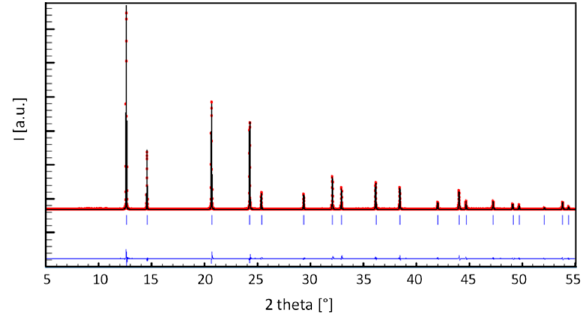
Figure 2. Rietveld refinement plot of sample NdDy20. The dotted (red) and the continuous (black) lines are the experimental and the calculated diffraction pattern, respectively. The lower line is the difference curve, and vertical bars show the calculated positions of Bragg peaks. Table 1. Values of x in Ce 1 − x (Nd 0.63 Dy 0.37 ) x O 2 − x /2 resulting from EDS, and Rietveld agreement factors.